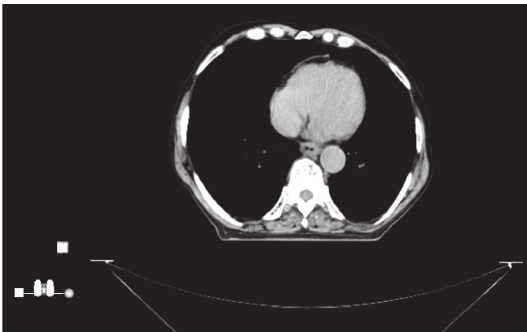
Figure 3: Pretreatment computed tomography showing circumferential esophageal wall thickening located at the distal third of the